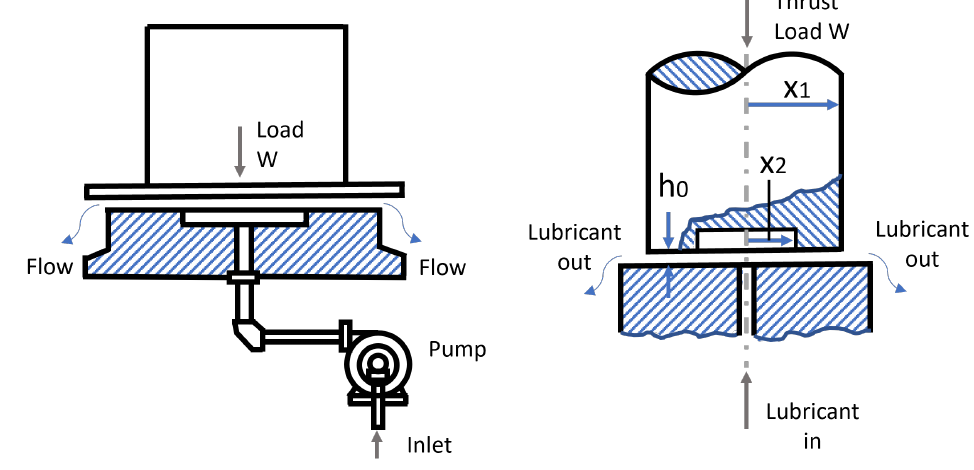
Figure 9. Schematic view of the hydrostatic thrust bearing design